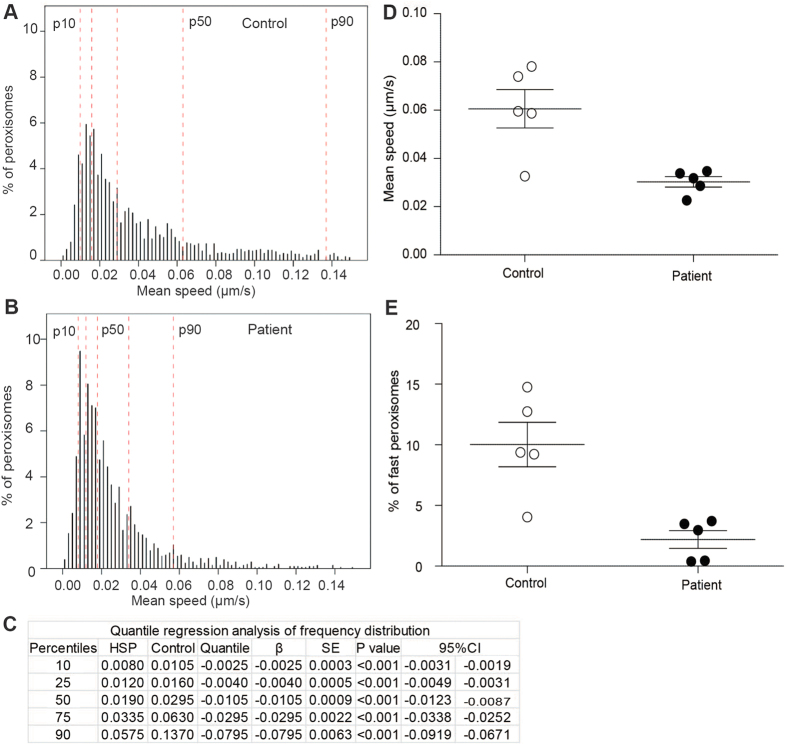
Reduced numbers of fast moving peroxisomes in patient cell axon-like processes.(A,B) Frequency distributions of peroxisome speeds in populations of peroxisomes from control (A; N = 2837 peroxisomes from 50 axon-like processes of 5 control cell lines) and patient axon-like processes (B; N = 2023 peroxisomes from 50 axon-like processes of 5 patient cell lines). The red dotted lines indicate the 10th, 25th, 50th, 75th and 90th percentiles of the frequency distribution. Compared to the control peroxisomes, the frequency distribution of the patient peroxisomes is shifted to the left, indicating a shift to more slowly moving peroxisomes. (C) Quantile regression analysis of the frequency distributions, showing a significant reduction at all percentiles in mean peroxisome speeds in patient cells (HSP) compared to control cells. For inter-percentile comparisons the patient-control difference (β), standard error (SE), significance (p-value) and 95% confidence interval (CI) values are shown. (N = 2837 peroxisomes from 50 control axon-like processes of 5 control cell lines and 2023 peroxisomes from 50 control axon-like processes of 5 control cell lines). (D) Mean speeds of peroxisomes travelling along patient and control axon-like processes. 2837 peroxisomes from 50 control axon-like processes of 5 control cell lines and 2023 peroxisomes from 50 control axon-like processes of 5 control cell lines were analysed. Average mean speeds of peroxisomes of all patient cell lines (solid circles) were compared to all control cell lines. N = 5 cell lines per group. Unpaired t-test; two tailed; p-value: 0.0064; t = 3.663 df = 8. Data are represented as Mean ± SEM. (E) Average percentage of fast moving peroxisomes of all patient cell lines (solid circles) were compared to all control cell lines (open circles). N = 5 cell lines per group. Unpaired t-test; two tailed; p-value: 0.0041; t = 3.975 df = 8. Data are represented as Mean ± SEM.